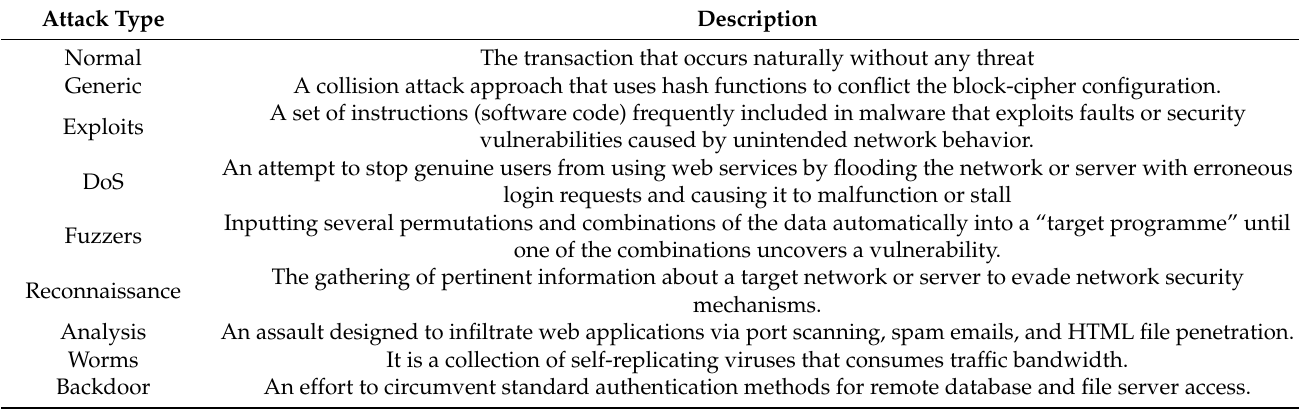
Table 2. Type of attacks present in the UNSW-NB15 dataset and their